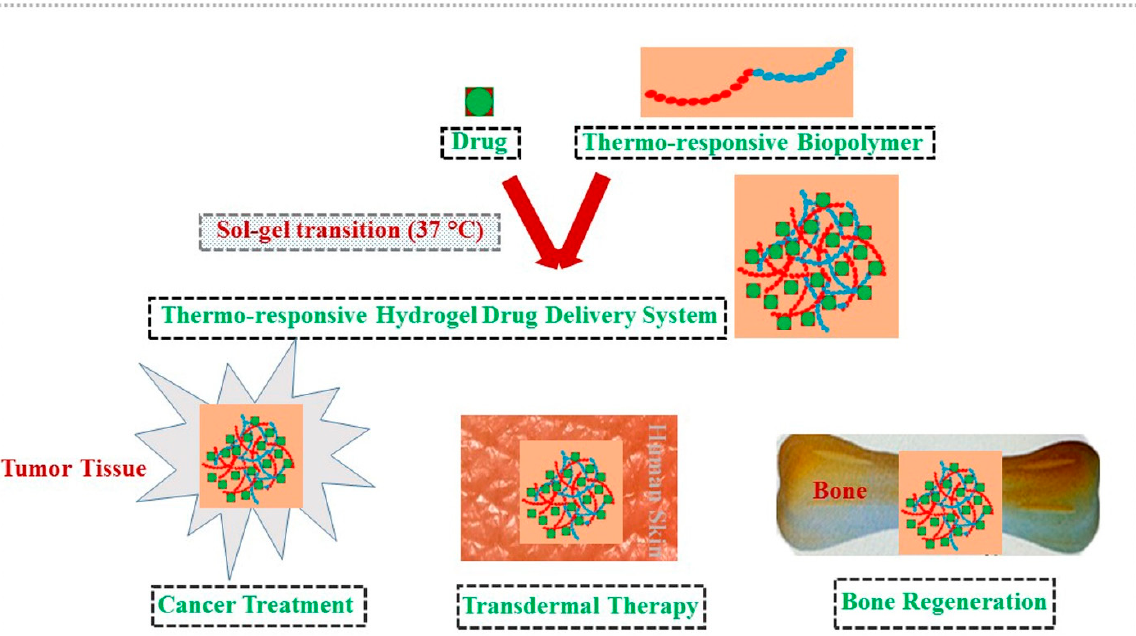
Figure 3. The formation of drug-loaded biopolymer-based thermo-responsive hydrogel system via in situ gel formation and its bio-medical applications including cancer treatment, transdermal, and bone regeneration (Flow-chart presentation).